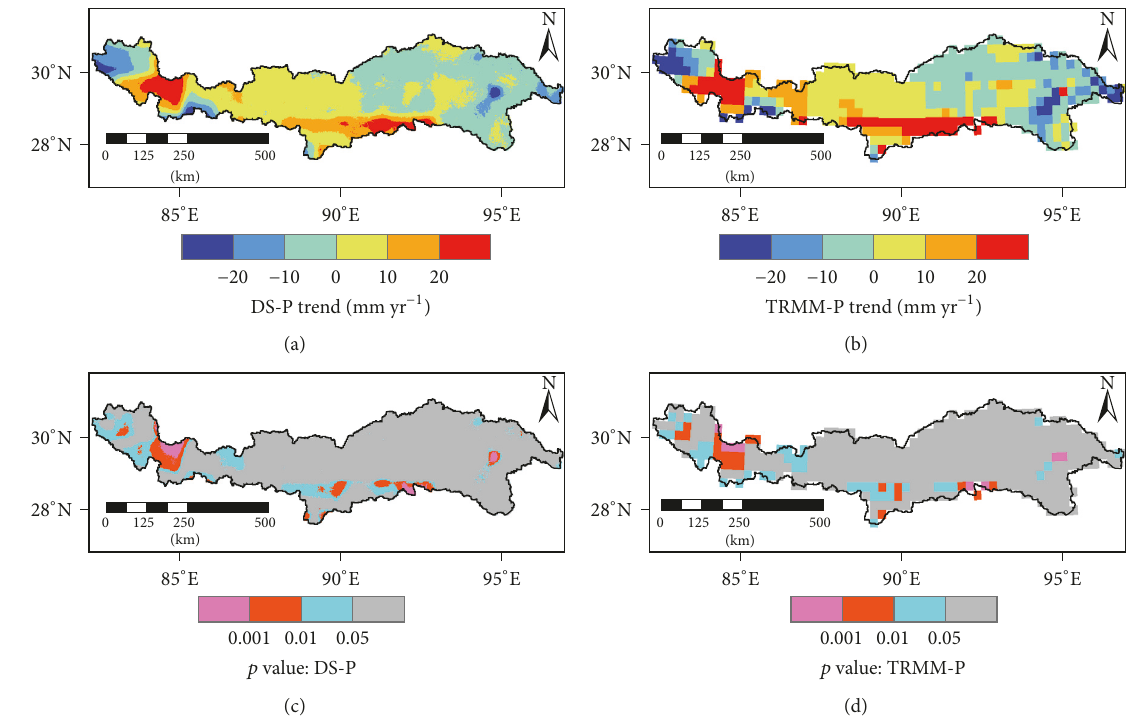
Figure 7: Changes in annual precipitation derived from (a) downscaled results (DS-P) and (b) TRMM 3B43 and the corresponding 𝑝 value statistics for the changes in (c) DS-P and (d) TRMM-P in the Yarlung Zangbo River Basin during the 2001–2014 period.